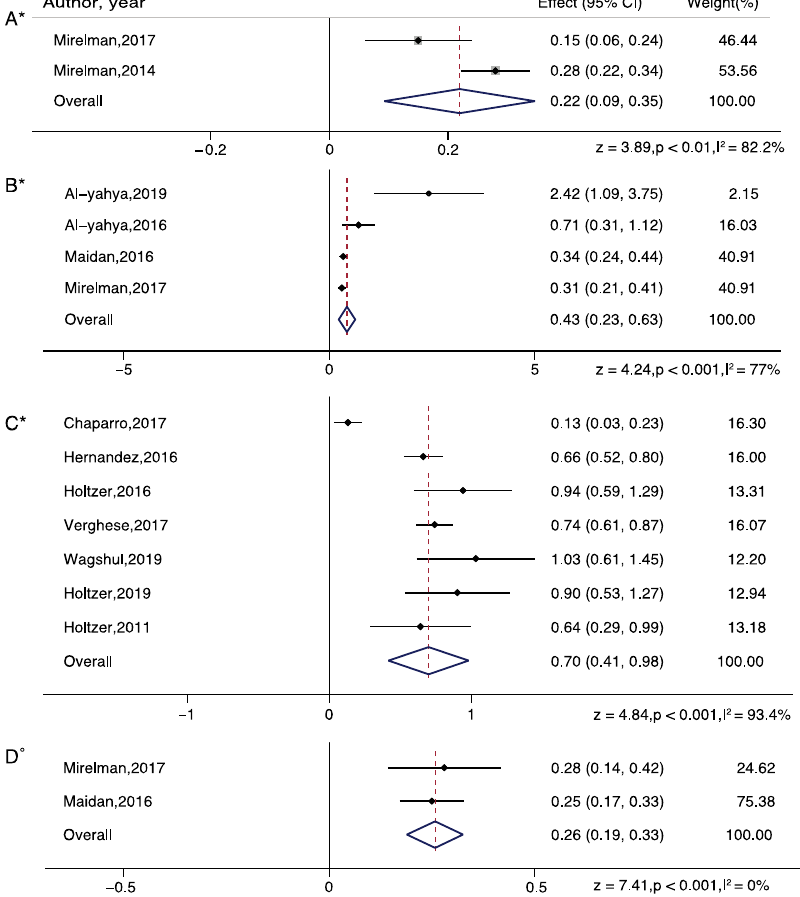
Figure 3. Brain activation differences while doing serial subtraction tasks in healthy young adults ( A ), and in serial subtraction tasks ( B ), letter generation tasks ( C ), or obstacle walking tasks ( D ) in healthy older adults. Note: ◦ represents Fixed plot meta-analysis, * represents Random plot meta-analysis [29–31,35,36,44,47,48,52,55,56,62].